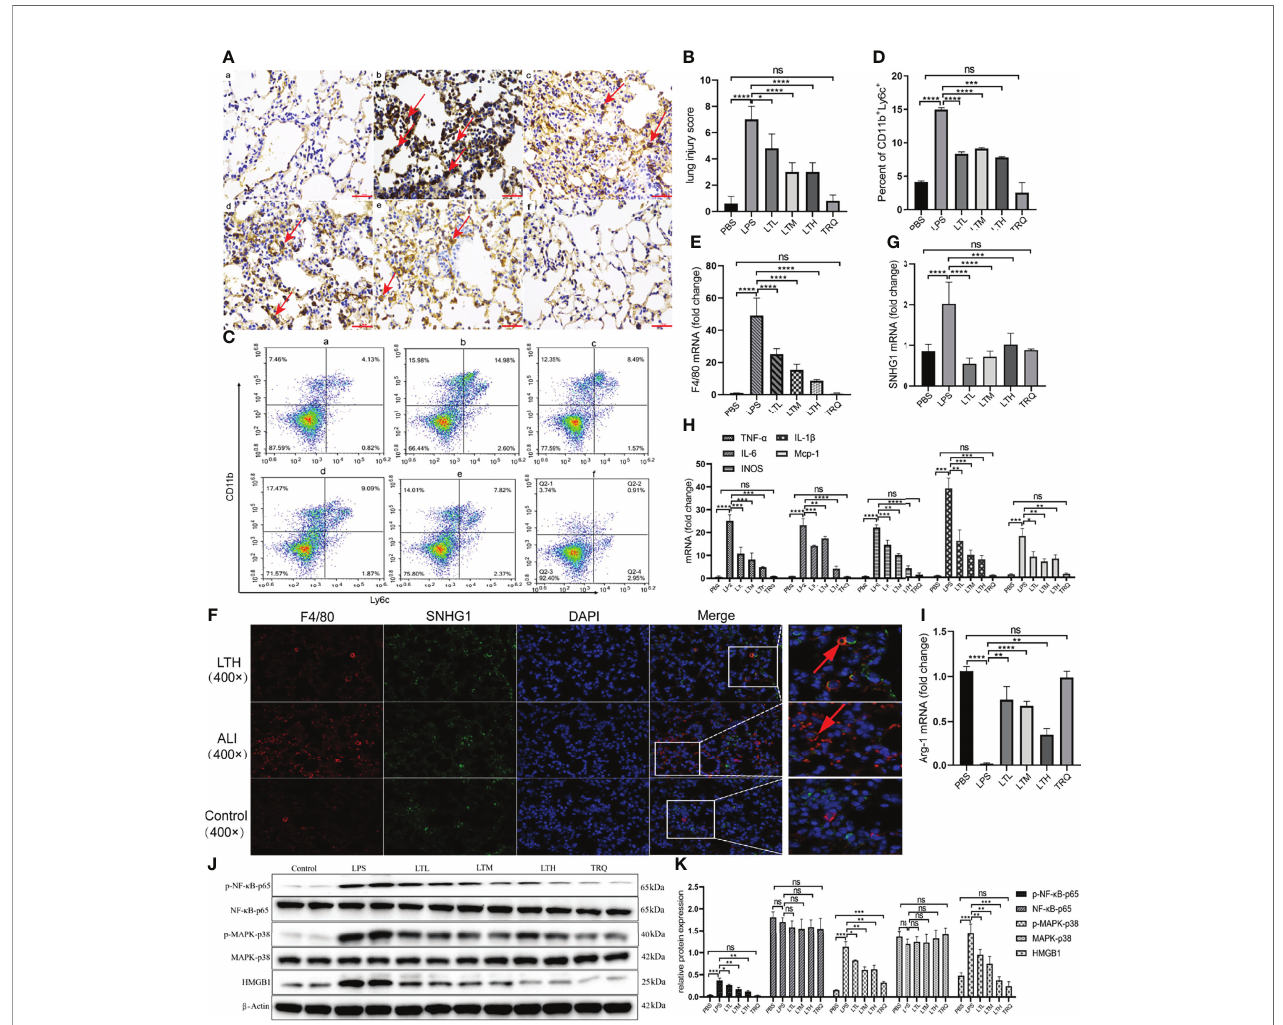
FIGURE 9 | TRQ regulates the activation of M1 macrophages and the expression of SNHG1. (A, B) IHC of F4/80 was performed to show the expression of macrophages in the control (a) , LPS (b) , LTL (c) , LTM (d) , LTH (e) and TRQ (f) groups (magni fi cation, ×100, scale bar, 100 m m). (C, D) The percentage of F4/80 +Ly6c+ M1 macrophages in the control (a) , LPS (b) , LTL (c) , LTM (d) , LTH (e) and TRQ (f) groups, as determined by fl ow cytometry. (E) The expression of F4/80 in the control, LPS, LTL, LTM, LTH and TRQ groups, as determined by qRT-PCR. (F) The expression of SNHG1 (green) was expressed on F4/80 (red) macrophages in control, ALI, LTH group, as determined by FISH assay. (G) The expression of SNHG1 in the control, LPS, LTL, LTM, LTH and TRQ groups, as determined by qRT-PCR. (H) The expression of proin fl ammatory cytokines (TNF- a , iNOS, IL-18, MCP-1, IL-6 and IL-1 b ) in the control, LPS, LTL, LTM, LTH and TRQ groups, as determined by qRT-PCR. (I) Anti-in fl ammatory cytokines (Arg-1) in the control, LPS, LTL, LTM, LTH and TRQ groups, as determined by qRT-PCR. (J, K) The expression of NF- k B-p65, p-NF- k B-p65, MARK-P38, p-MARK-P38 and HMGB1 in the in the control, LPS, LTL, LTM, LTH and TRQ groups, as determined by Western Blot. Data are indicated as the mean ± SD, ns, P ≥ 0.05, * P <0.05, ** P <0.01, *** P <0.001, **** P